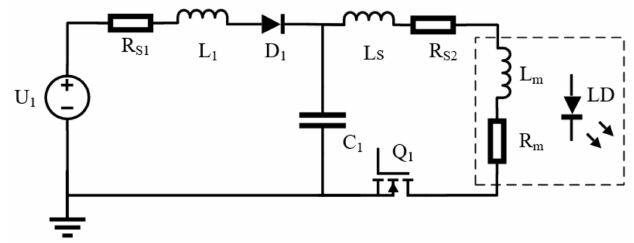
Figure 6. Actual circuit schematic with parasitic